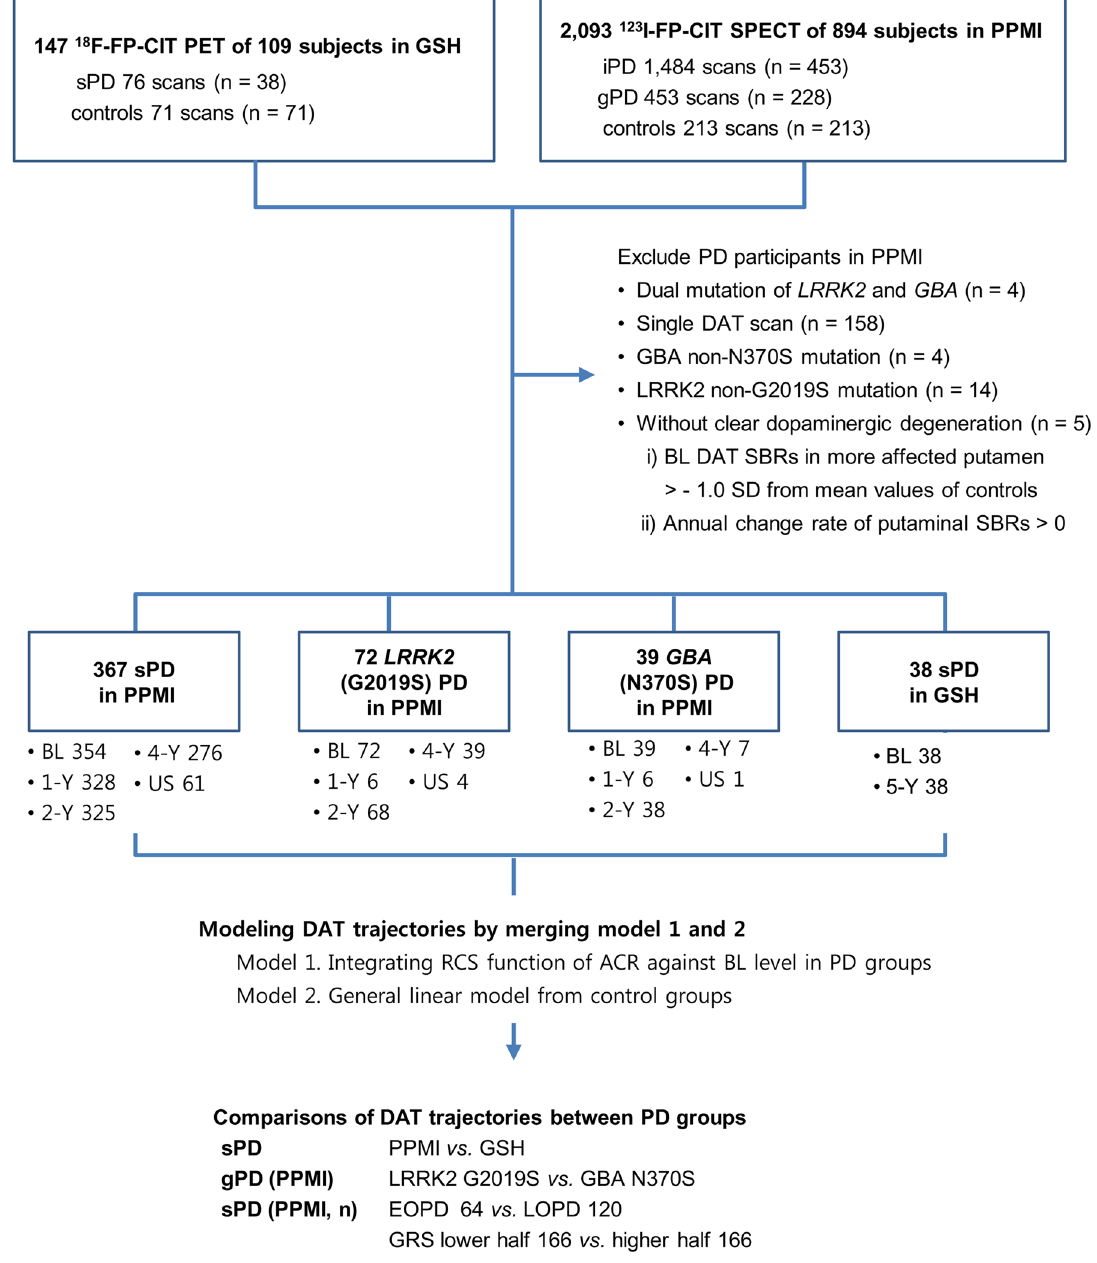
Fig. 1 Study design. GSH = Gangnam Severance Hospital cohort; PPMI = Parkinson ’ s Progression Markers Initiative; PET = positron emission tomography; SPECT = single-photon emission computed tomography; iPD = idiopathic PD cohort in PPMI study; sPD = sporadic PD cases; gPD = genetic PD cohort in PPMI study; DAT = dopamine transporter; SBR = speci fi c binding ratio; SC = screening visit in each cohort; BL = baseline; 1, 2, 4, 5-Y = 1, 2, 4, 5-year follow-up visit; US = unscheduled visit; F/U = follow-up; RCS = restricted cubic spline; ACR = annual change rate; AAO = age at onset; GRS = genetic risk score; *comparison within the PPMI GRS 0.16/year vs. high GRS 0.14/year). When sPD patients were rates (estimate = 0.023, SE = 0.012, p = 0.049). In comparisons of the categorized by GRS quartiles, higher GRS quartiles were associated RCS fi ts, the high-GRS group showed less annual change in the with earlier onset of DAT decline and a slower SBR reduction rate baseline SBR range over 1.2 than low-GRS patients (Fig. 4a). GRSs in during the premotor stage (Supplementary Fig. 2). the patients were associated with early AAO (Pearson ’ s correlation test, ρ = − 0.136, p = 0.013), suggesting a leftward shift in estimated trajectory for the high-GRS group. In addition, GRSs exhibited a signi fi cant negative correlation with SBRs at motor onset (Pearson ’ s correlation test, ρ = − 0.115, p = 0.036). As a result, patients with high GRS showed a longer premotor phase (high vs. low GRS, − 10.9 vs. − 9.5 years), and a slightly slower decline in putaminal dopaminergic activity (Fig. 4b; SBR reduction rate during premotor phase, and low